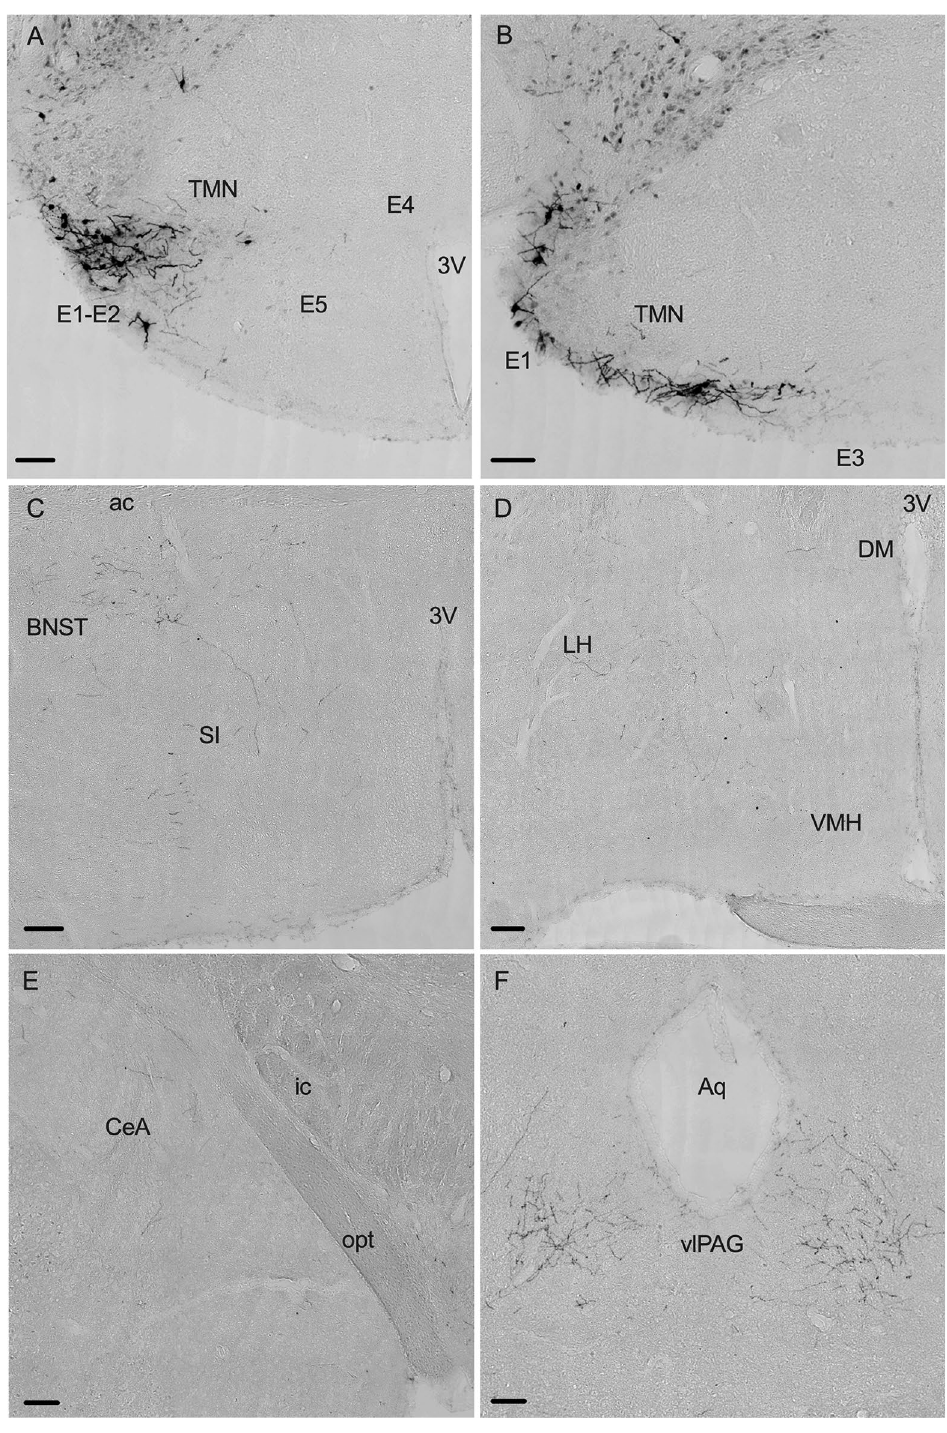
Figure 6. Projection targets of HA TMN neurons. The presence of mCherry-immunoreactive HA TMN somata and fibres were examined in coronal brain sections 6 months after AAV injections. ( A ) mCherry-immunoreactive HA TMN neuronal somata and fibres in the ventrolateral TMN. ( B ) mCherry-immunoreactive HA TMN neuronal somata and fibres in the caudal TMN. ( C ‒ F ) HA TMN fibres in the bed nucleus of the stria terminalis (BNST) ( C ), lateral hypothalamus (LH) ( D ), central amygdala (CeA) ( E) and ventrolateral periaqueductal grey (vlPAG) ( F). Scale bar = 100 μm. ac anterior commissure, Aq aqueduct, DM dorsomedial hypothalamic nucleus, LH lateral hypothalamus, opt optic tract, SI substantia innominate, TMN tuberomamillary nucleus, VMH ventromedial hypothalamic nucleus, 3 V third ventricle. E1–E5, neuronal clusters of HA TMN . Anterior–posterior locations (mm from bregma): ( A ) − 2.18 mm, ( B ) − 2.70 mm, ( C ) 0.14 mm, ( D ) − 0.46 mm, ( E ) − 1.34 mm and ( F ) − 4.24